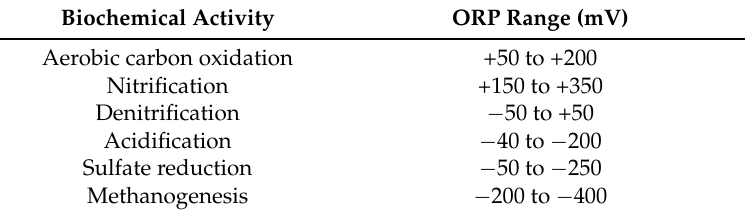
Table 1. The oxidation reduction potential range (ORP) of common compounds present in